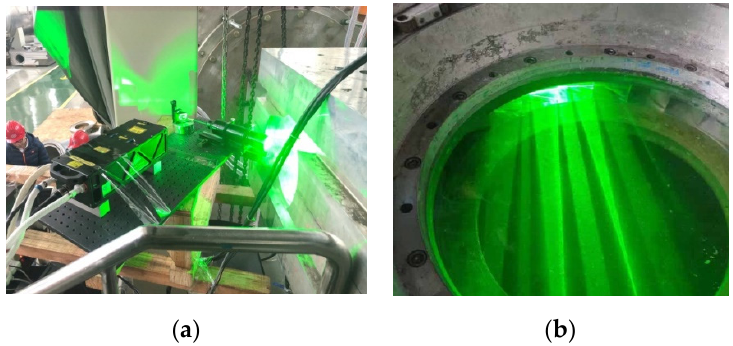
Figure 3. Light path: ( a ) incident laser; ( b ) internal effect.